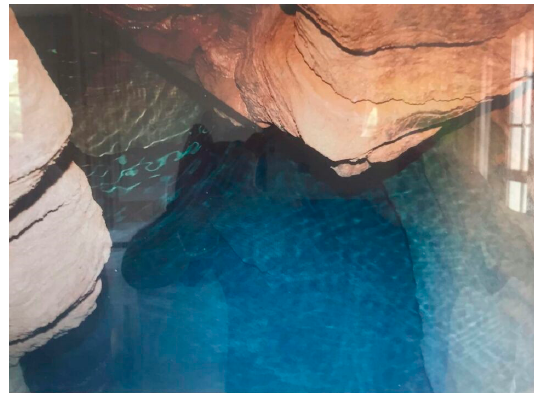
Figure 11. Exposed water-bearing karst cave.